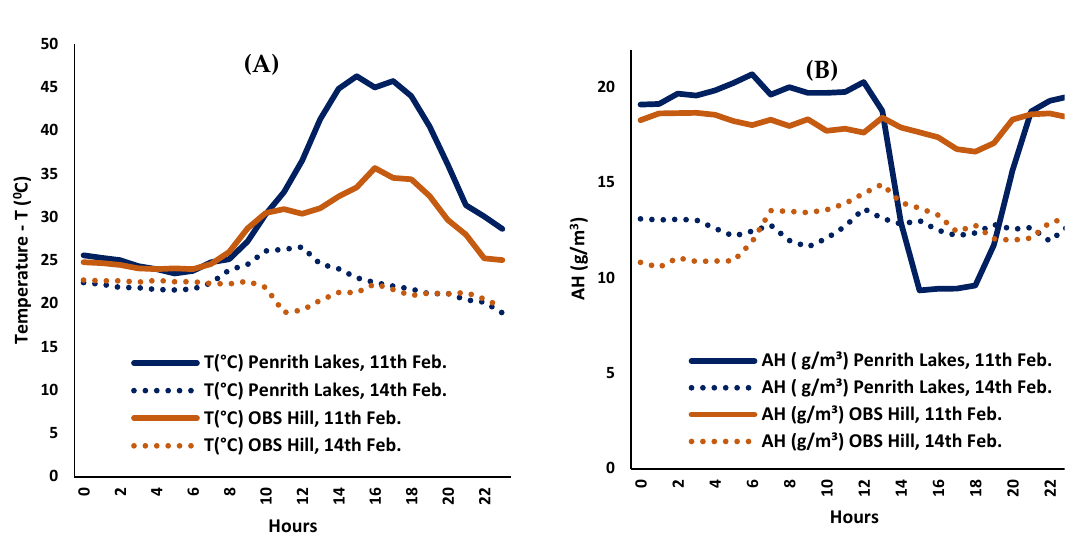
Figure 6. Nocturnal ambient temperatures & dew point temperatures at Penrith Lakes & OBS Hill during HW (9–11 February 2017) and NHW periods. ( A ) during the HW and ( B ) NHW period.